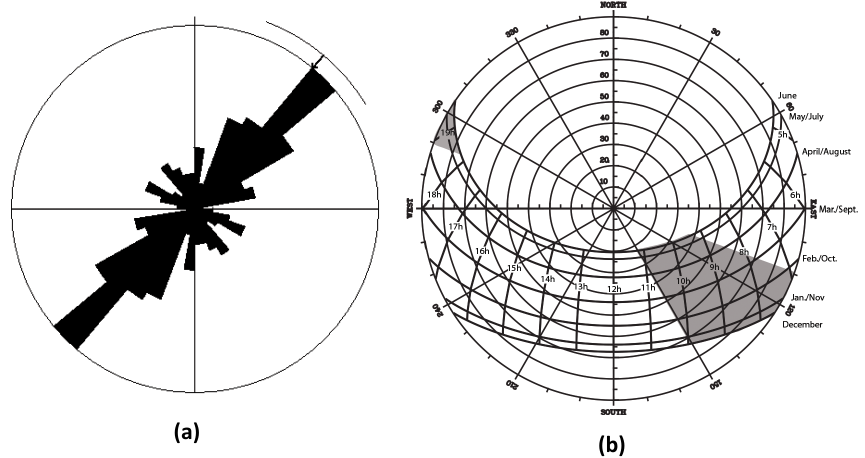
Fig. 4. Modified from Eppes et al. (2010). A. Rose diagram of measured crack orientations from 101 rocks in the Gobi Desert. Arc represents 2 σ mean resultant direction of data (40 ◦ northeast). B. Sunpath solar path chart for the Gobi field site. Modified from a chart created through the University of Oregon Solar Radiation Monitoring Laboratory website. Shaded areas represent instances when the sun would be at a 90 ◦ angle from average crack angle of 40 ◦ . This type of field data is exemplary of this and other studies that show that rock cracks exhibit preferred orientations (e.g., Eppes et al., 2010; McFadden et al., 2005). If cracks form perpendicular to the direction of heating and cooling, then these preferred orientations suggest that cracks form due to stresses that arise in the morning (Eppes et al.,